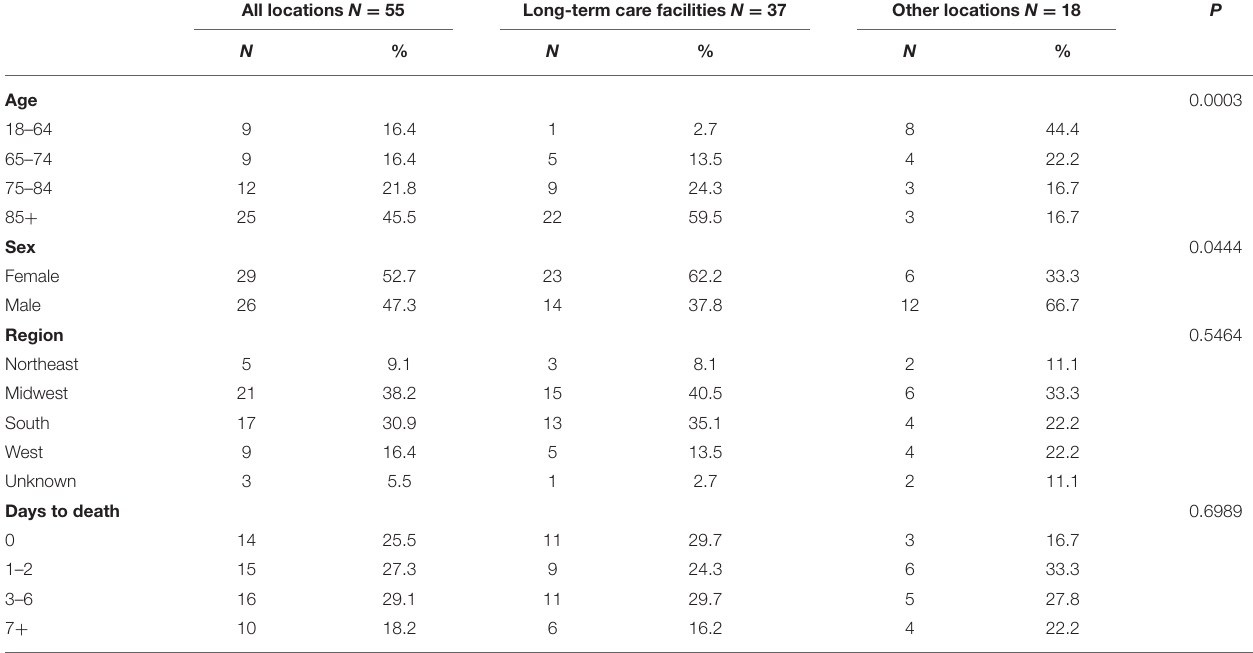
TABLE 1 | Characteristics of deaths following COVID-19 vaccination in the U.S. ( N = 55). All locations N =